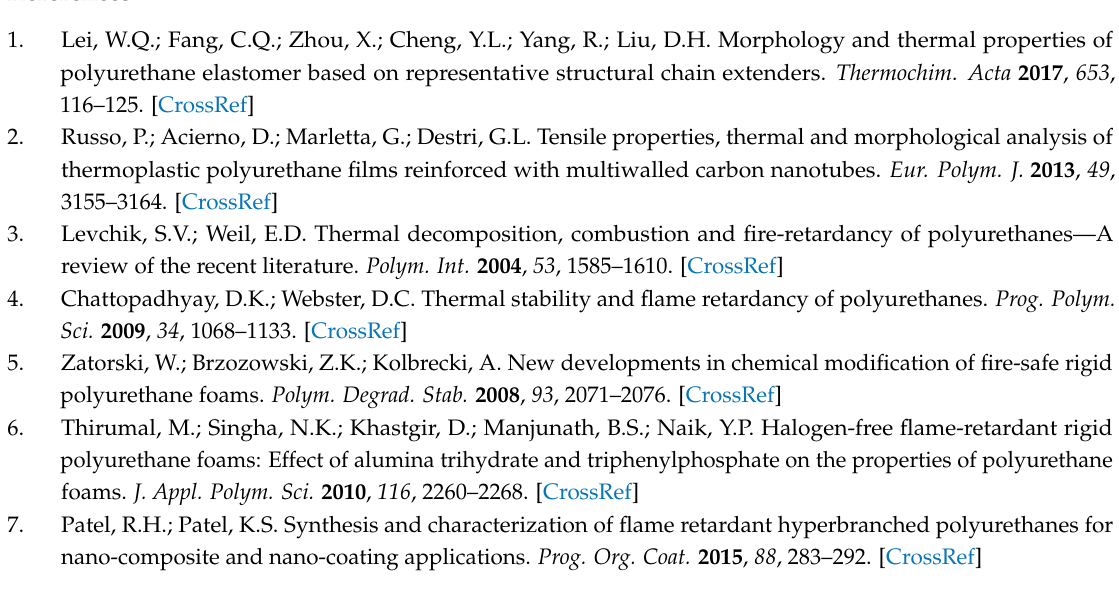
Figure S1: GPC data of EPPU-2, intensity vs retention time (min), Figure S2: DSC data for